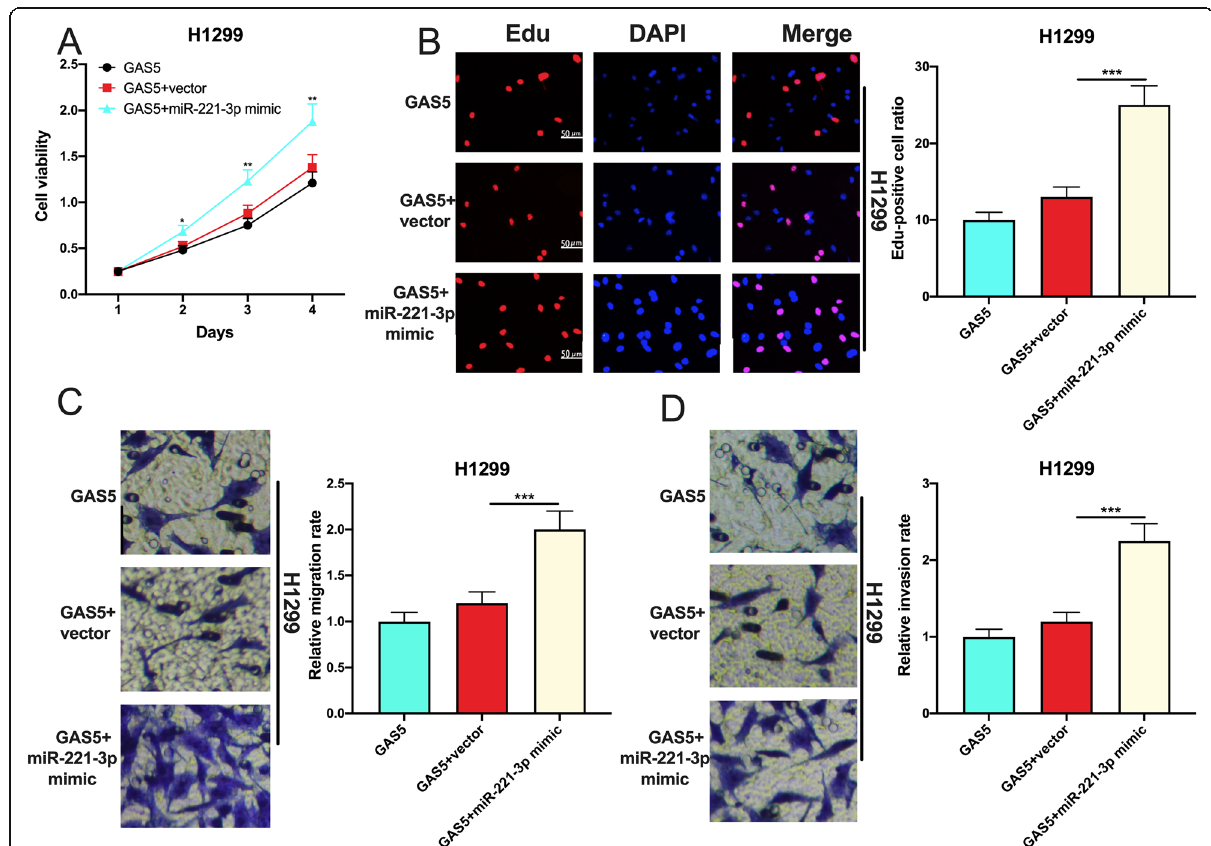
Fig. 5 MiR-221-3p counteracted the biological functions of GAS5 on NSCLC cells. a The effects of co-transfection of GAS5 overexpression plasmid and miR-221-3p mimics on H1299 cell viability were detected by CCK-8 experiment. b The effects of co-transfection of GAS5 overexpression plasmid and miR-221-3p mimics on the proliferation of H1299 cells were detected by EdU assay. c , d Transwell experiment was conducted to detect the effects of co-transfection of GAS5 overexpression plasmid and miR-221-3p mimics on H1299 cell. *, **, *** represent p < 0.05, p < 0.01, and p < 0.001,